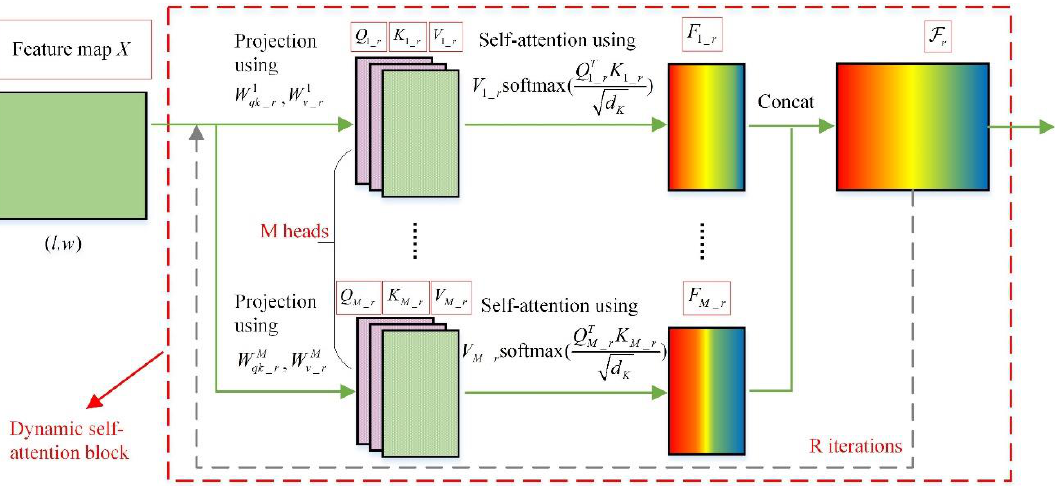
Figure 5. The structure of the dynamic